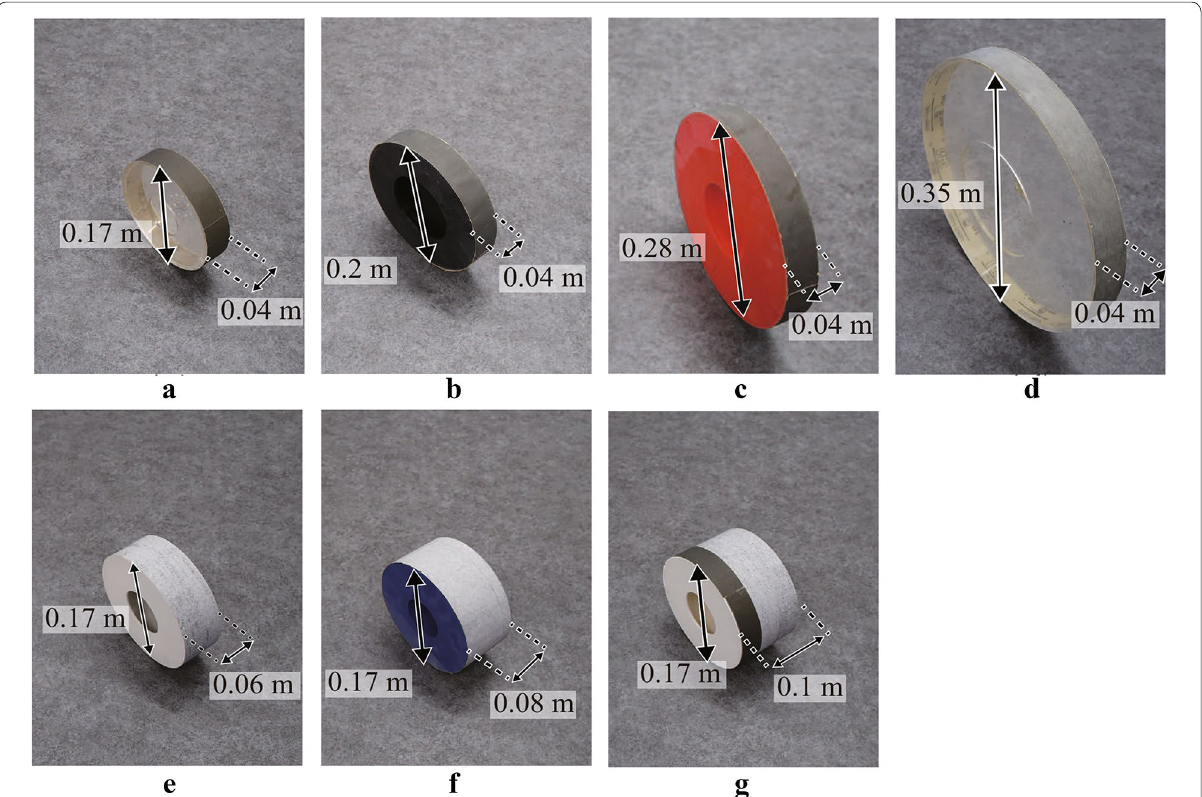
Fig. 8 Each wheel for the test. a Diameter 0.17 m, width 0.04 m, b Diameter 0.2 m, width 0.04 m, c Diameter 0.28 m, width 0.04 m. d Diameter 0.35